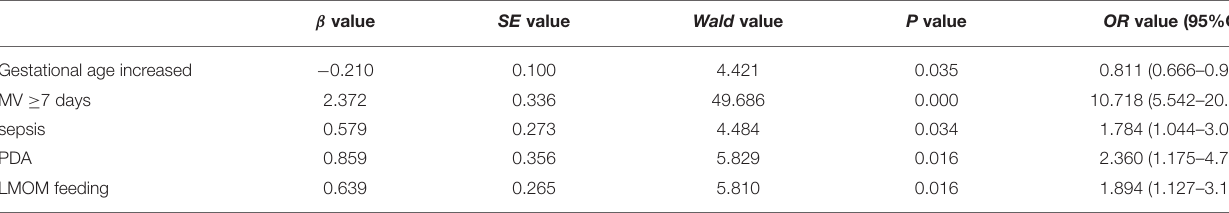
TABLE 4 | Multivariate logistic regression analysis of factors affecting moderate and severe BPD. β